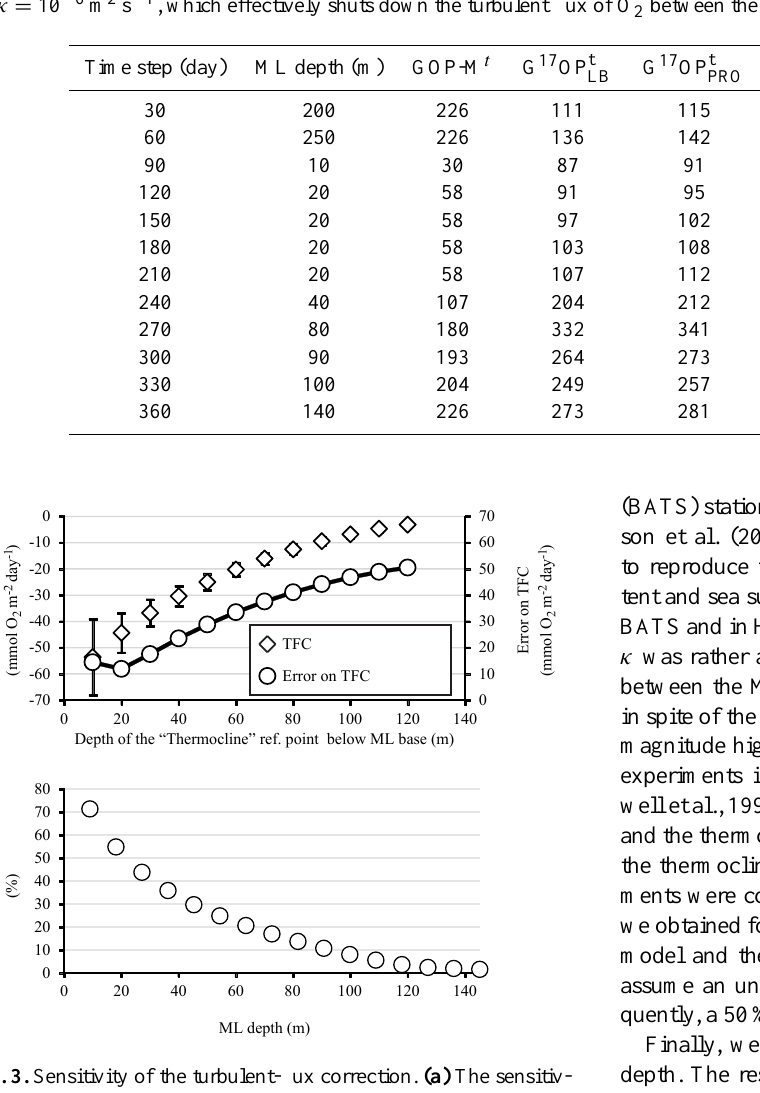
Table 2. Results of model simulation of GOP with varying mixed-layer depth ML – mixed layer, GOP-M – input GOP rate, G 17 OP LB – Luz and Barkan (2000), G 17 OP PRO – Prokopenko et al. (2011), G 17 OP C – this work includes a correction for turbulent flux of O 2 from the thermocline. All GOP rates are in mmolm − 2 day − 1 . In the columns marked with t, κ = 10 − 4 m 2 s − 1 , whereas in the columns marked with